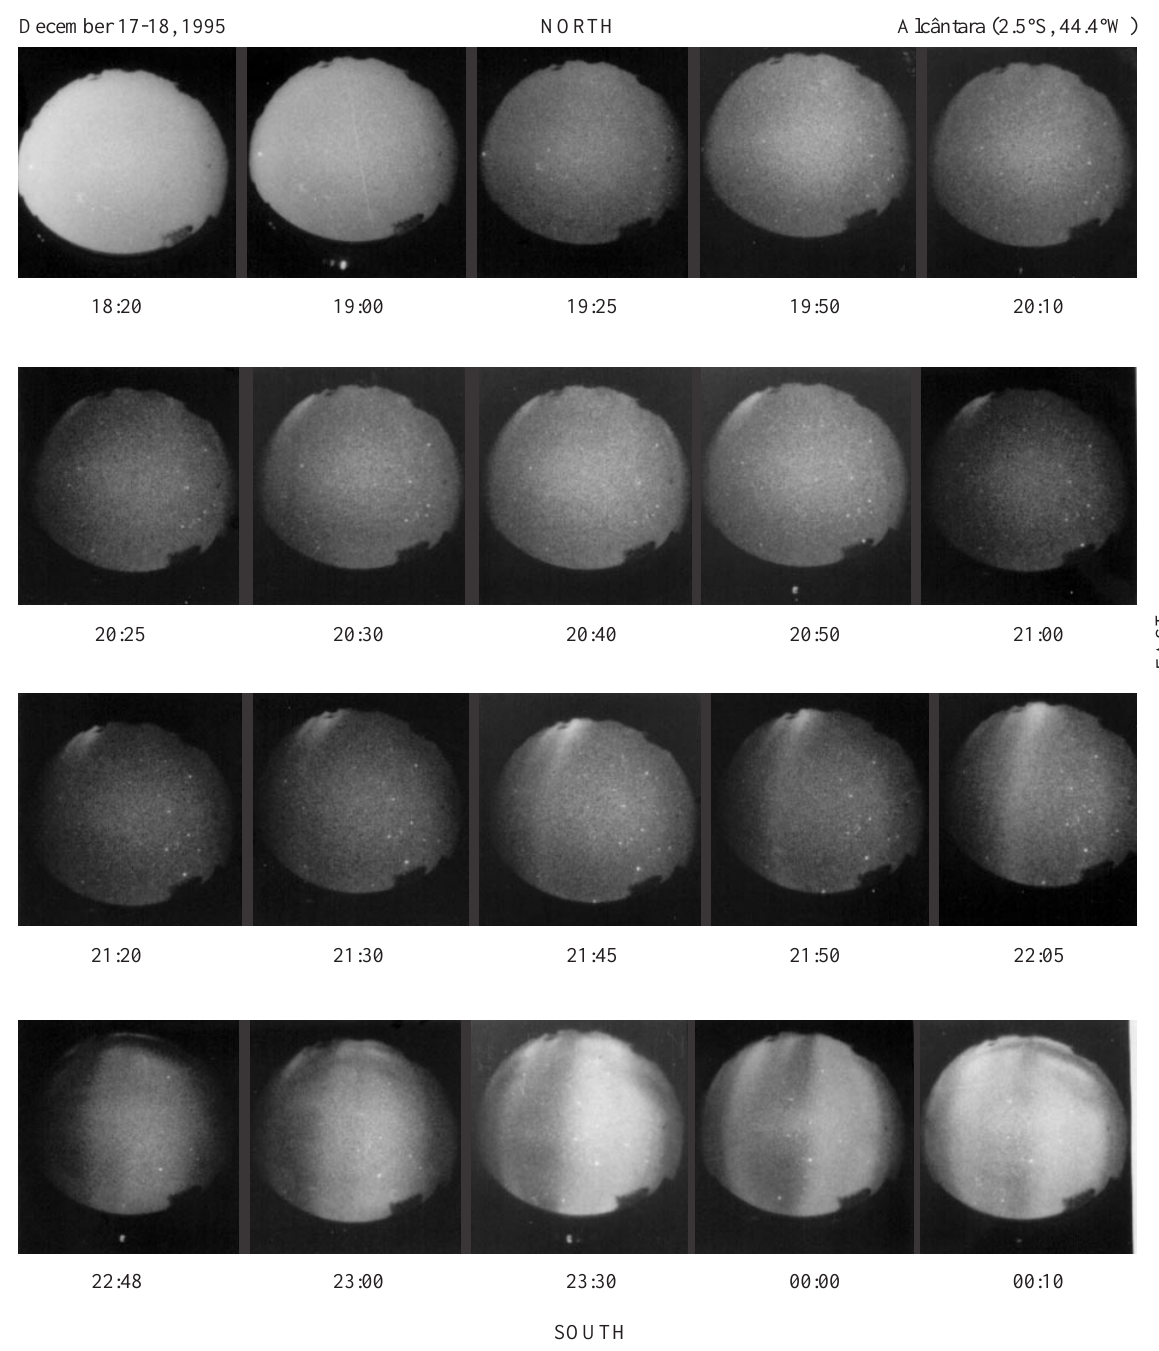
Fig. 5. Same as Fig. 3, but for December